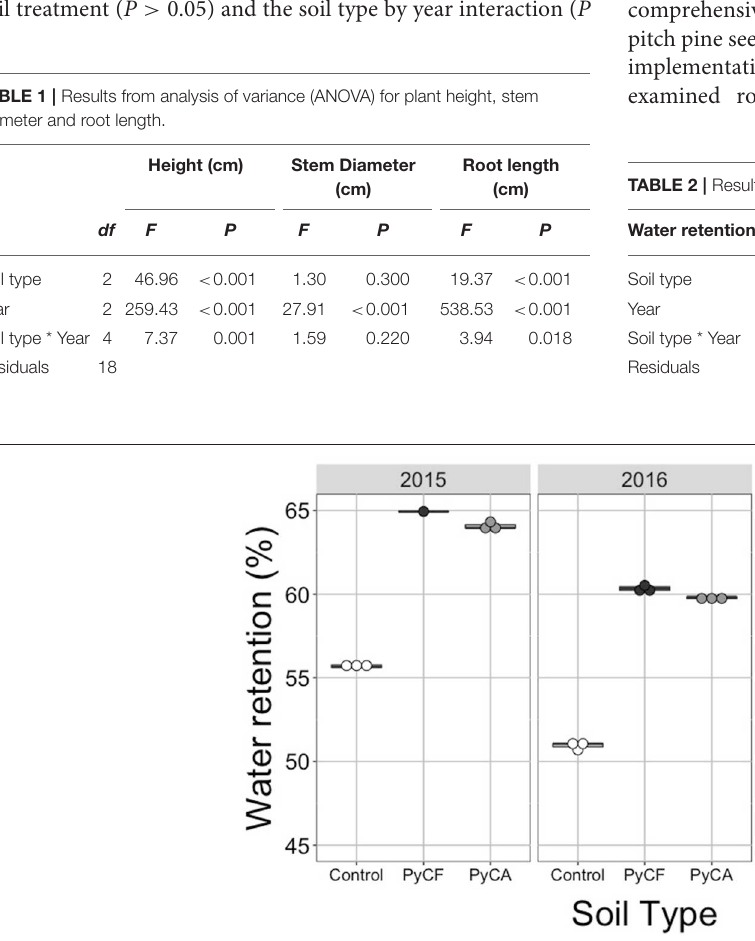
Frontiers in Forests and Global Change |